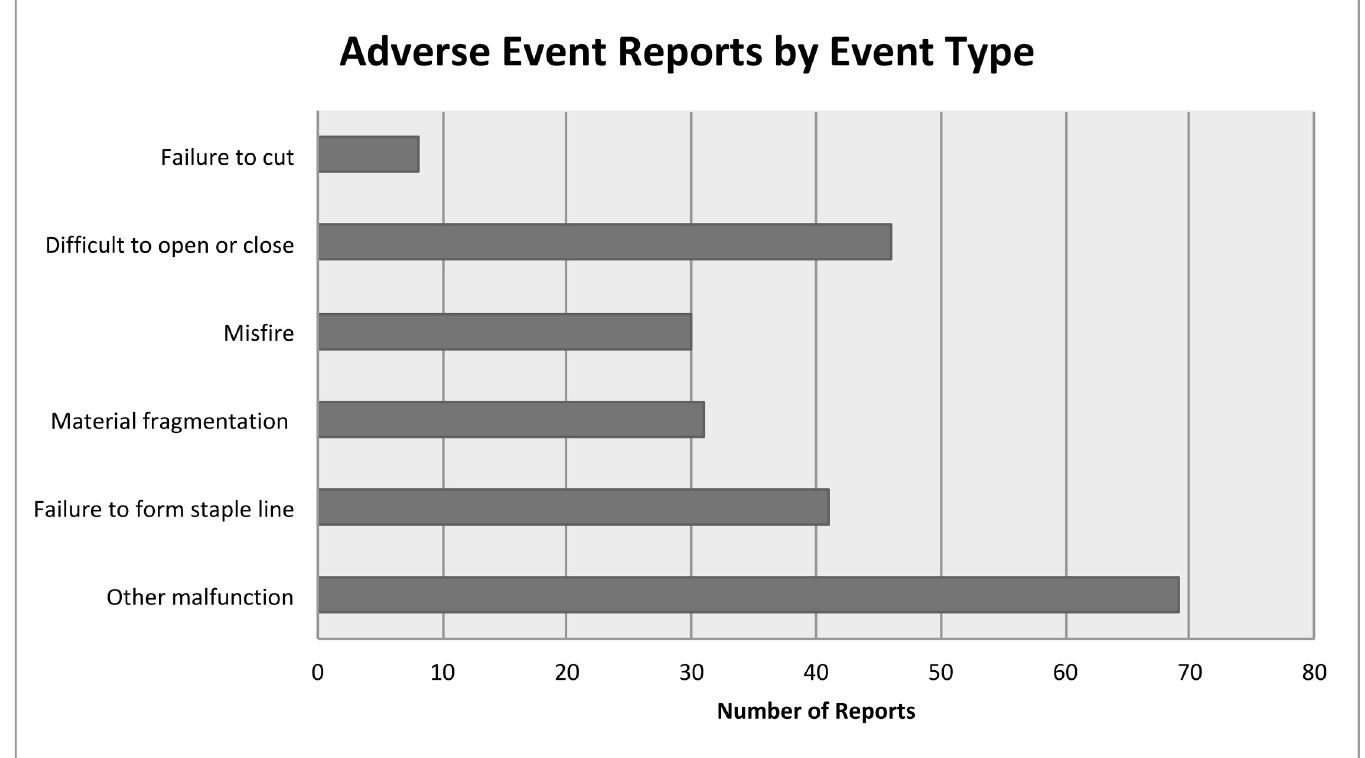
Fig 2. Complications related to robotic stapler use by adverse event